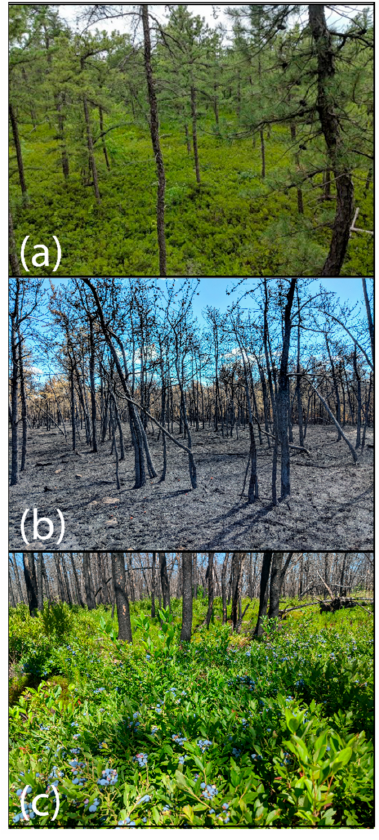
Figure 2. Representative photos of Altona Flat Rock pine barrens ( a ) outside of 2018 wildfire perimeter (reference condition summer 2018), ( b ) inside perimeter of 2018 wildfire (disturbed condition summer 2018), and ( c ) inside perimeter of 2018 wildfire 2 years after the disturbance. Both ( a ) and ( b ) photos were taken in August 2018—within one month following the wildfire. Photo ( c ) was taken